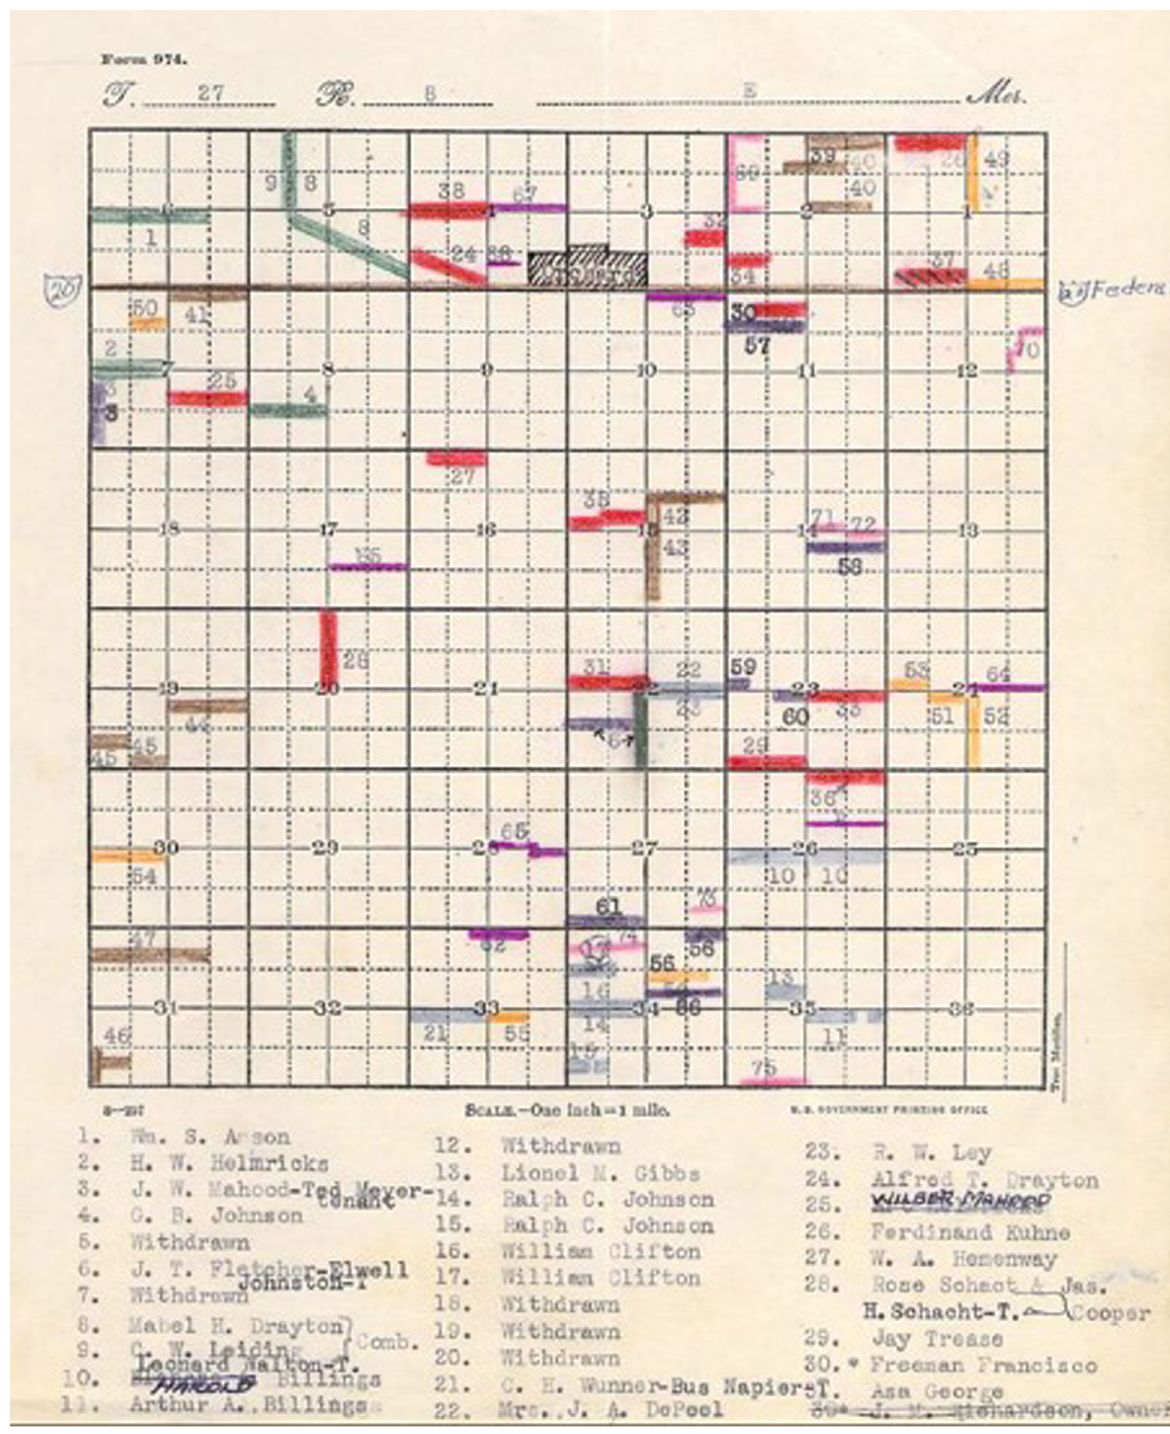
Fig. 5 Archival Source Township Map. Township map with cooperator ’ s name and farm number (Farm #25 changed ownership Art Helmrick – Wilber MaHood) . (Source: National Agroforestry Centre – Forest